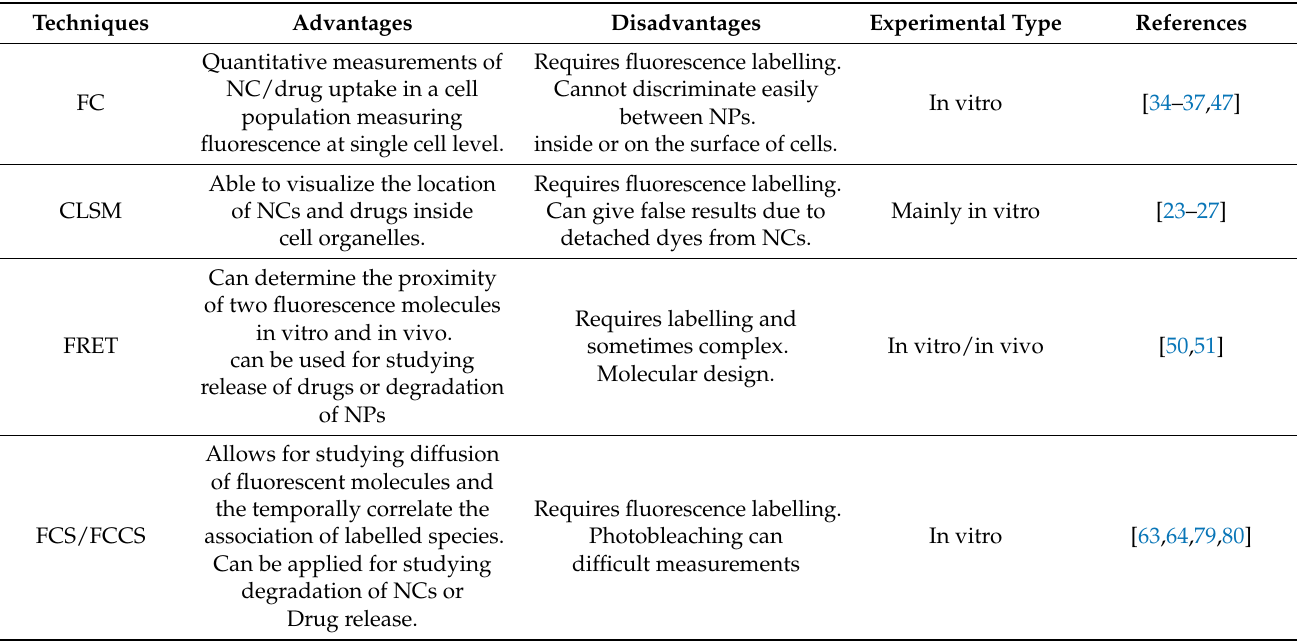
Table 1. Summary of the techniques presented, highlighting their advantages and disadvantages for fate studies in vitro and in